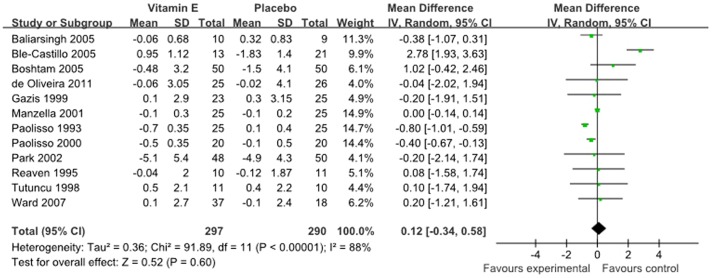
Forest plot of randomised controlled trials investigate the effect of vitamin E supplementation on fasting glucose.